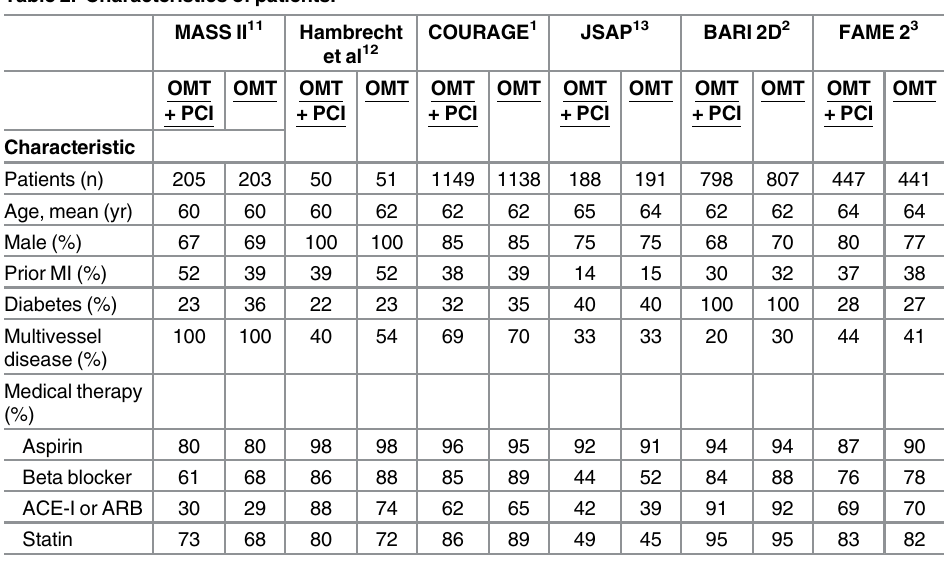
ACE-I = angiotensin converting enzyme inhibitors; ARB = angiotensin receptor blockers; BARI 2 = Bypass Angioplasty Revascularization Investigation 2 Diabetes; COURAGE = Clinical Outcome Utilizing Revascularization and Aggressive Drug Evaluation; FAME 2 = Fracional Flow Reserve versus Angiography for Multivessel Evaluation 2; JSAP = Japanese stable angina pectoris study; MASS II = The Medicine, Angioplasty, or Surgery Study II, MI = myocardial infarction, OMT = optimal medical therapy; PCI = percutaneous coronary